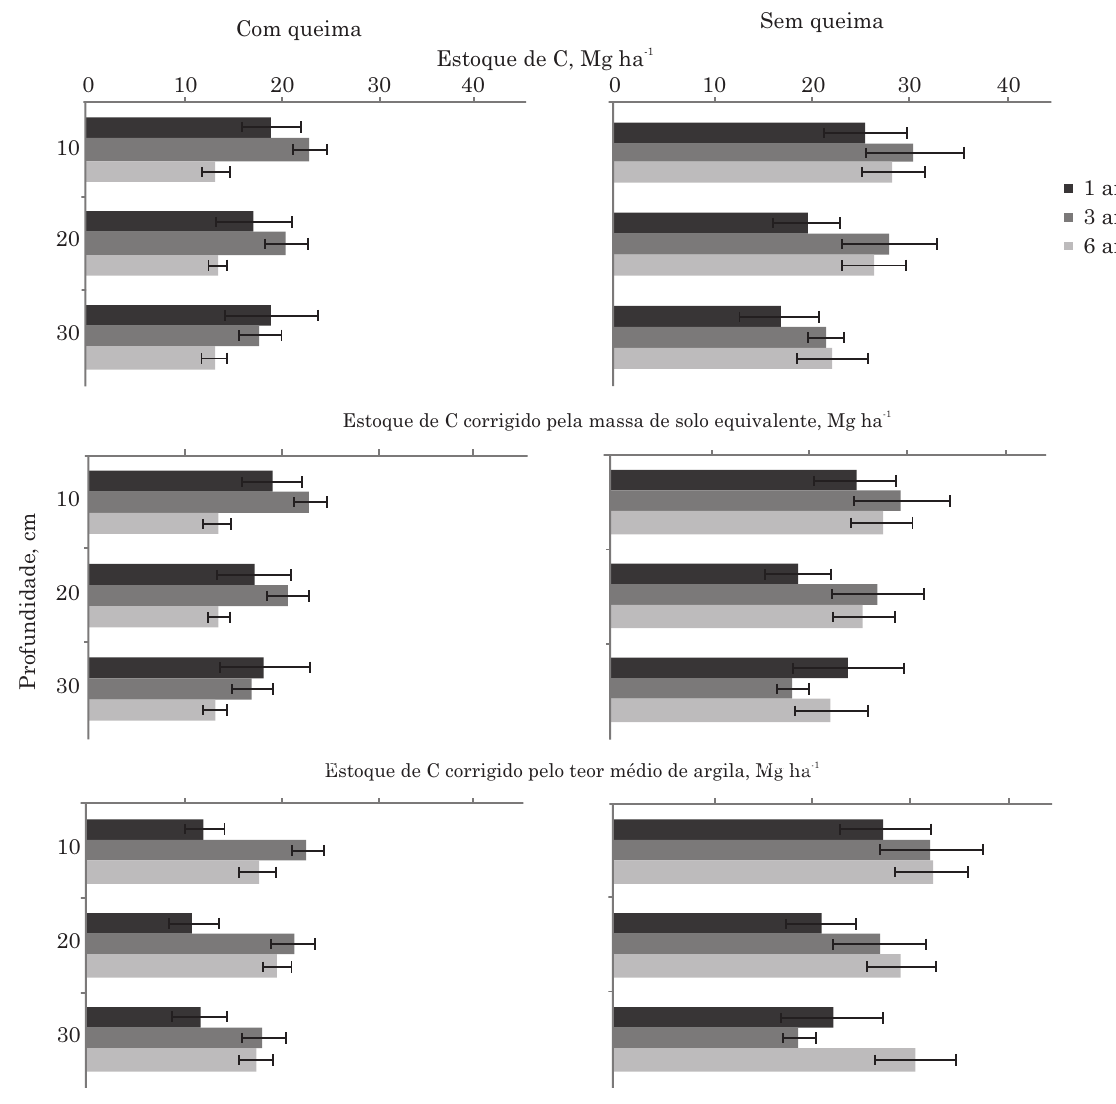
Figura 2. Estoques de C, estoques de C corrigidos pela massa de solo equivalente e estoques de C corrigidos pelo teor médio de argila em cronossequências de cana-de-açúcar colhida com e sem queima da palha. Barras indicam o intervalo de confiança das médias (p=0,95; n=9).